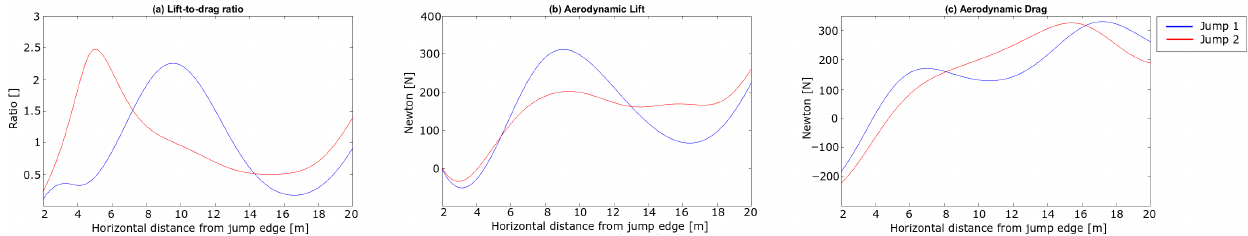
Figure 11. External forces acting on the ski jumper during the early flight phase for the jumps in the case study. ( a ) shows the lift-to-drag ratio ( F L / F D ), ( b ) the aerodynamic lift ( F L ) and ( c ) the aerodynamic drag ( F D ). The horizontal length from the in-run edge is shown on the x-axis. On the vertical axis the unit less ratio is shown in ( a ) and the force [N] in ( b , c